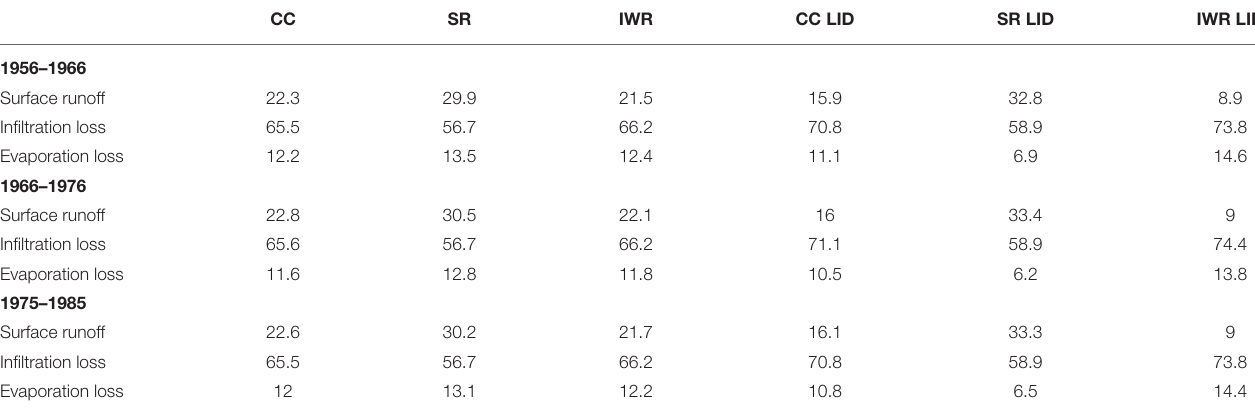
TABLE 3 | Fate of precipitation as a percentage of total precipitation from 10-year continuous simulations for scenarios without LID (first three columns) and with LID (three columns at right). CC SR